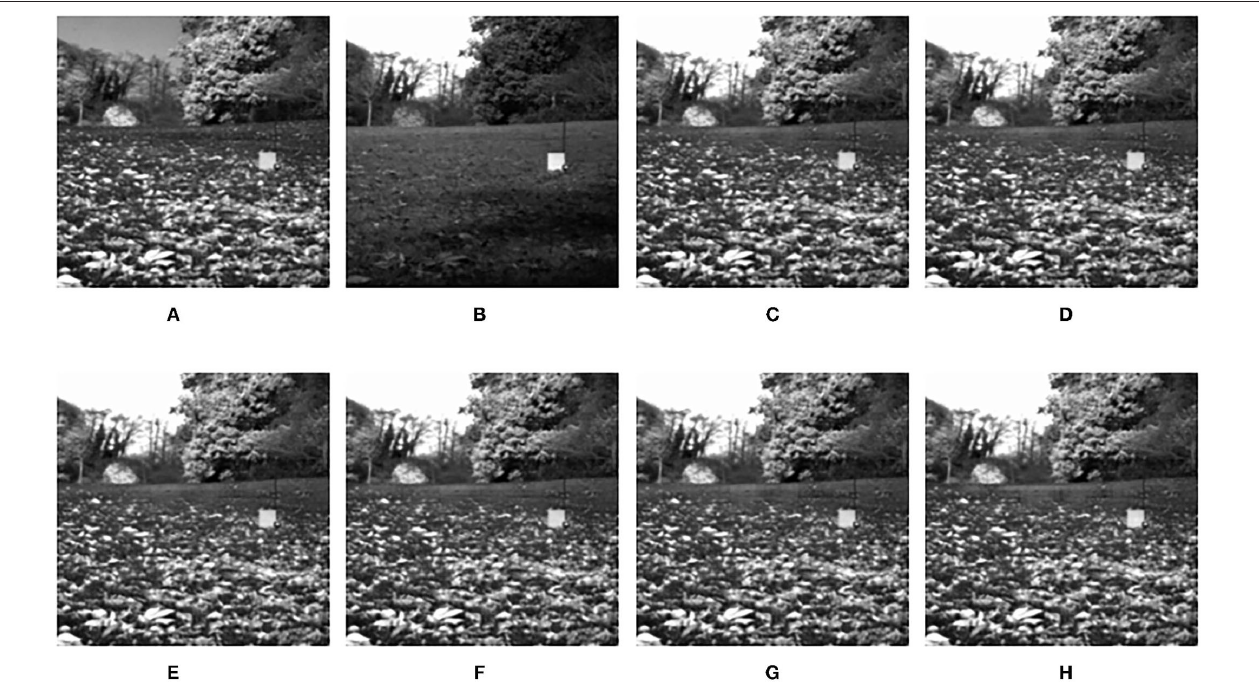
FIGURE 6 | The output fused images in step size experiment. (A) original image (infrared image); (B) original image (visible image); (C) step size = 1; (D) step size = 2; (E) step size = 4; (F) step size = 6; (G) step size = 8; (H) step size = 10.